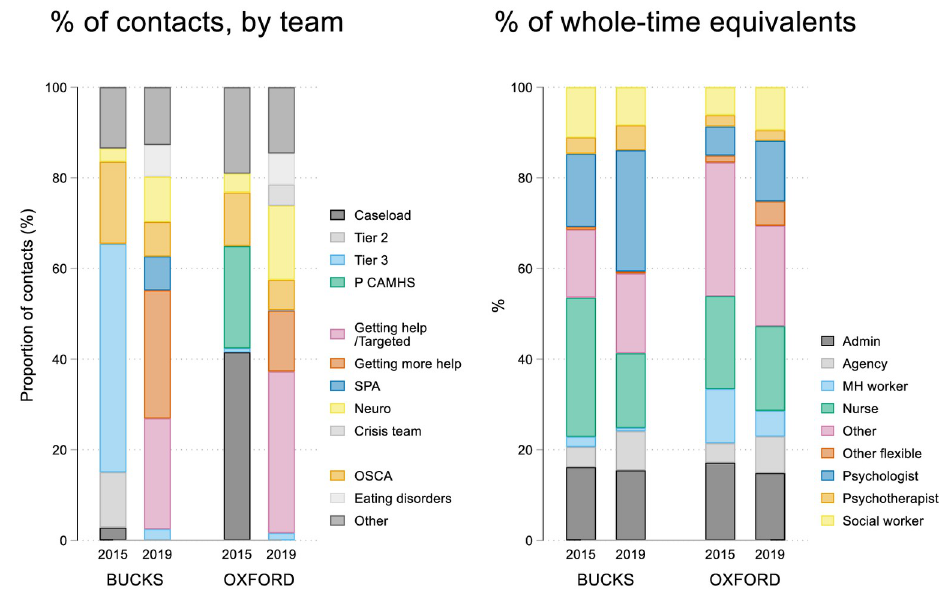
Fig 3. Proportion of patients seen by team and their whole-time